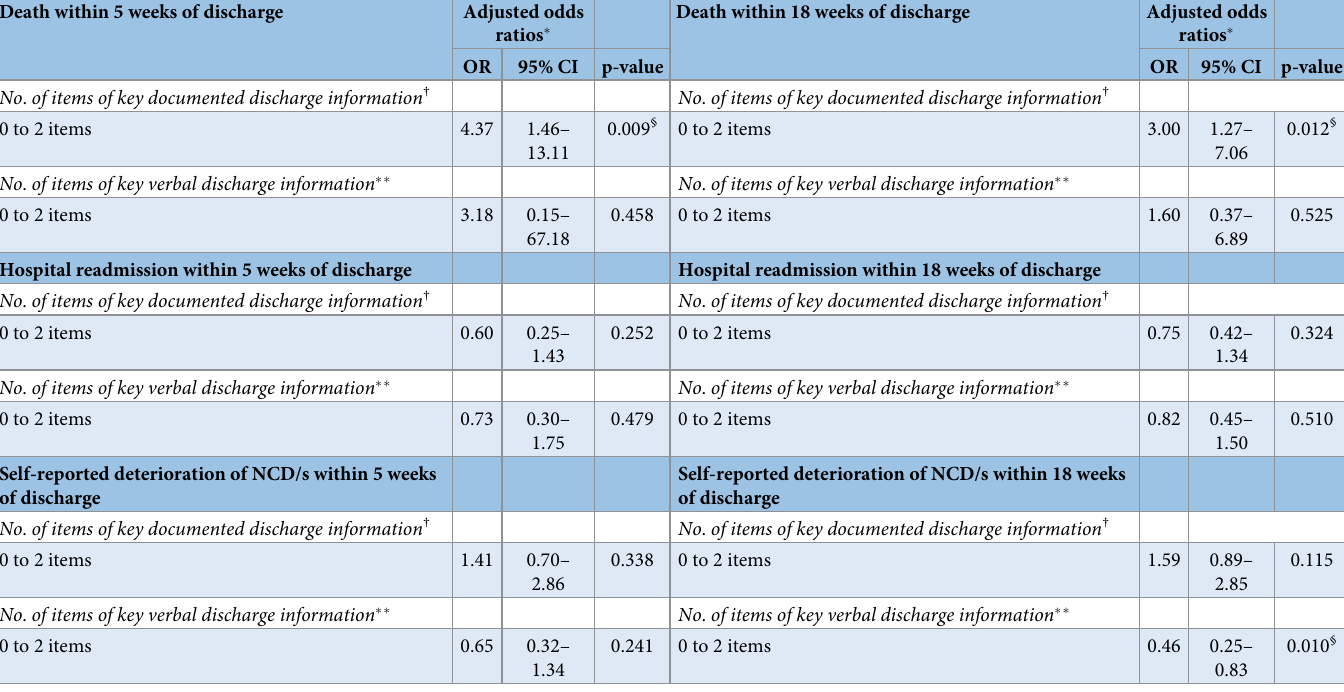
Table 4. Adjusted associations between receiving low-quality discharge communication and the likelihood of experiencing adverse health outcomes within five and eighteen weeks of